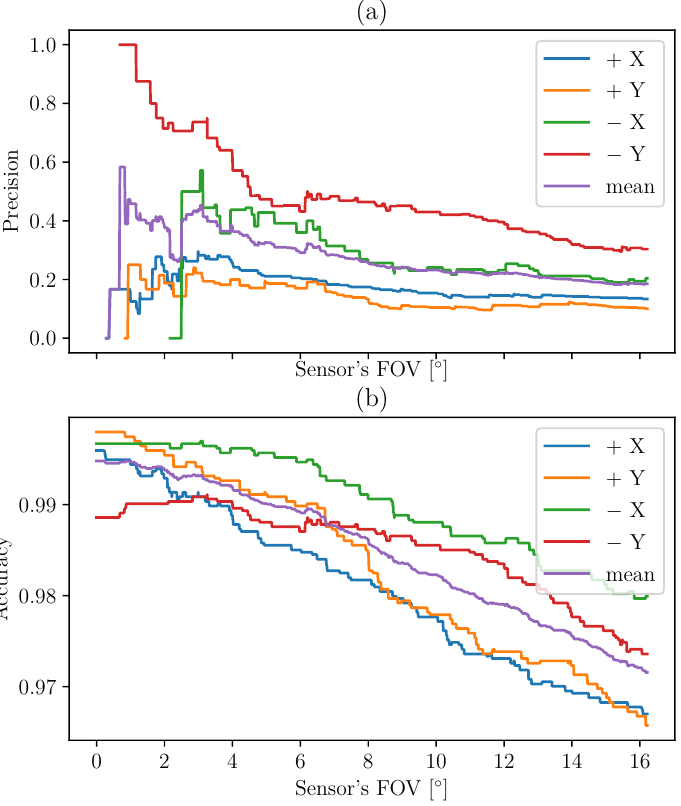
Figure 11. Precision ( a ) and accuracy ( b ) of the TRIAD method based on the UVS indicator. The indicators are plotted according to different FOV. Indeed, the FOV of the instru- ment can be different from the theoretical FOV due to uncertainties of measurements and misalignments. This is the reason why we choose to calculate the accuracy and precision for different values of angle threshold (theoretical FOV). When the angle between the normal to the sensor and the Sun LOS determined by each method is below a certain threshold (FOV), it is verified that the UVS sensor receives a signal corresponding to the incident solar flux. This is an indicator that the considered face is facing the Sun. Using large numbers of values corresponding to large numbers of different configurations helps us to quantify the ability of the methods to recover the Sun LOS in the body